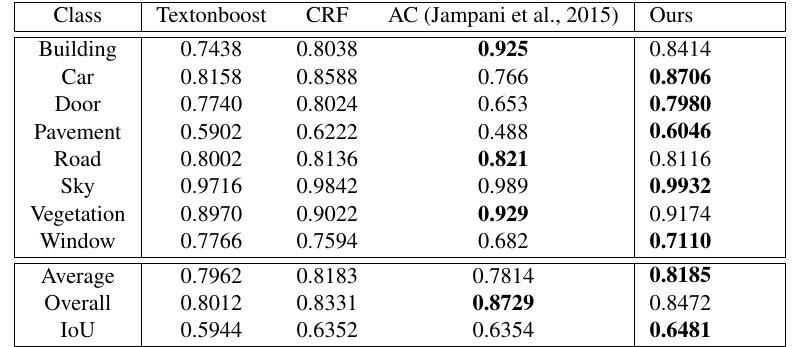
Table 1. The quantitative results on the eTRIMS dataset. Textonboost is trained using Automatic Labelling Environment. The CRF is a 4-connected CRF. AC is the Auto-context method. Our method is the fully connected CRF.